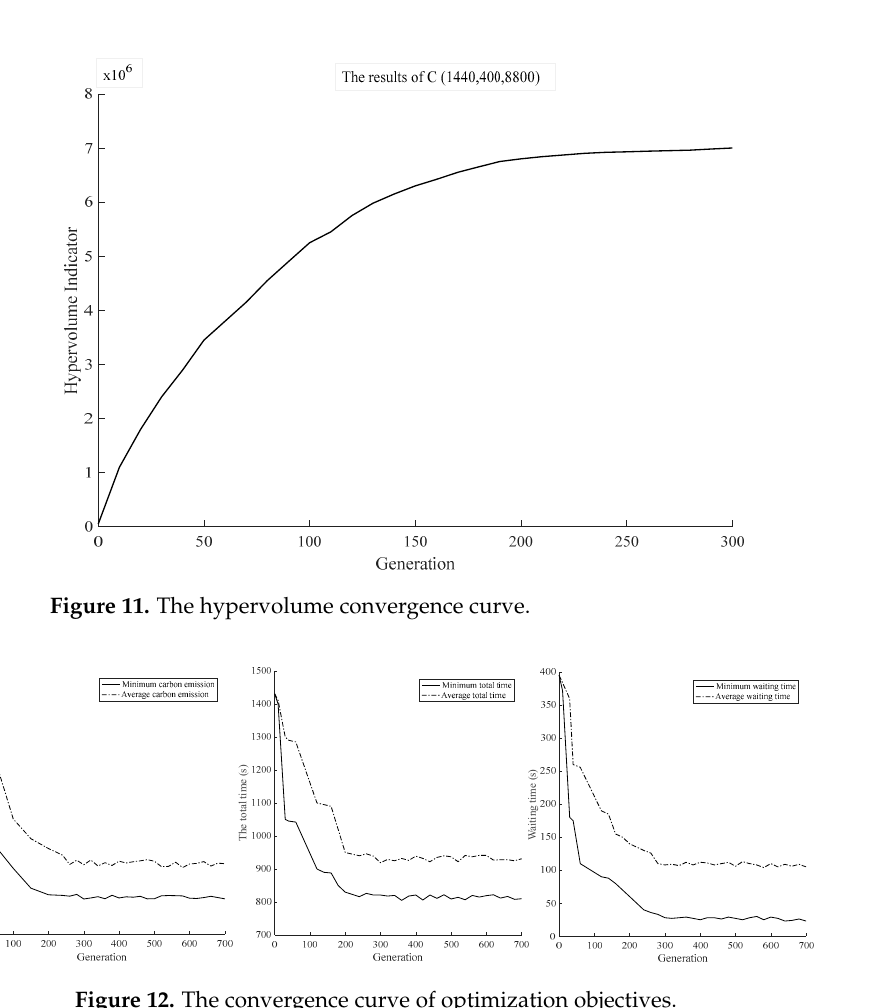
Figure 12. The convergence curve of optimization objectives.